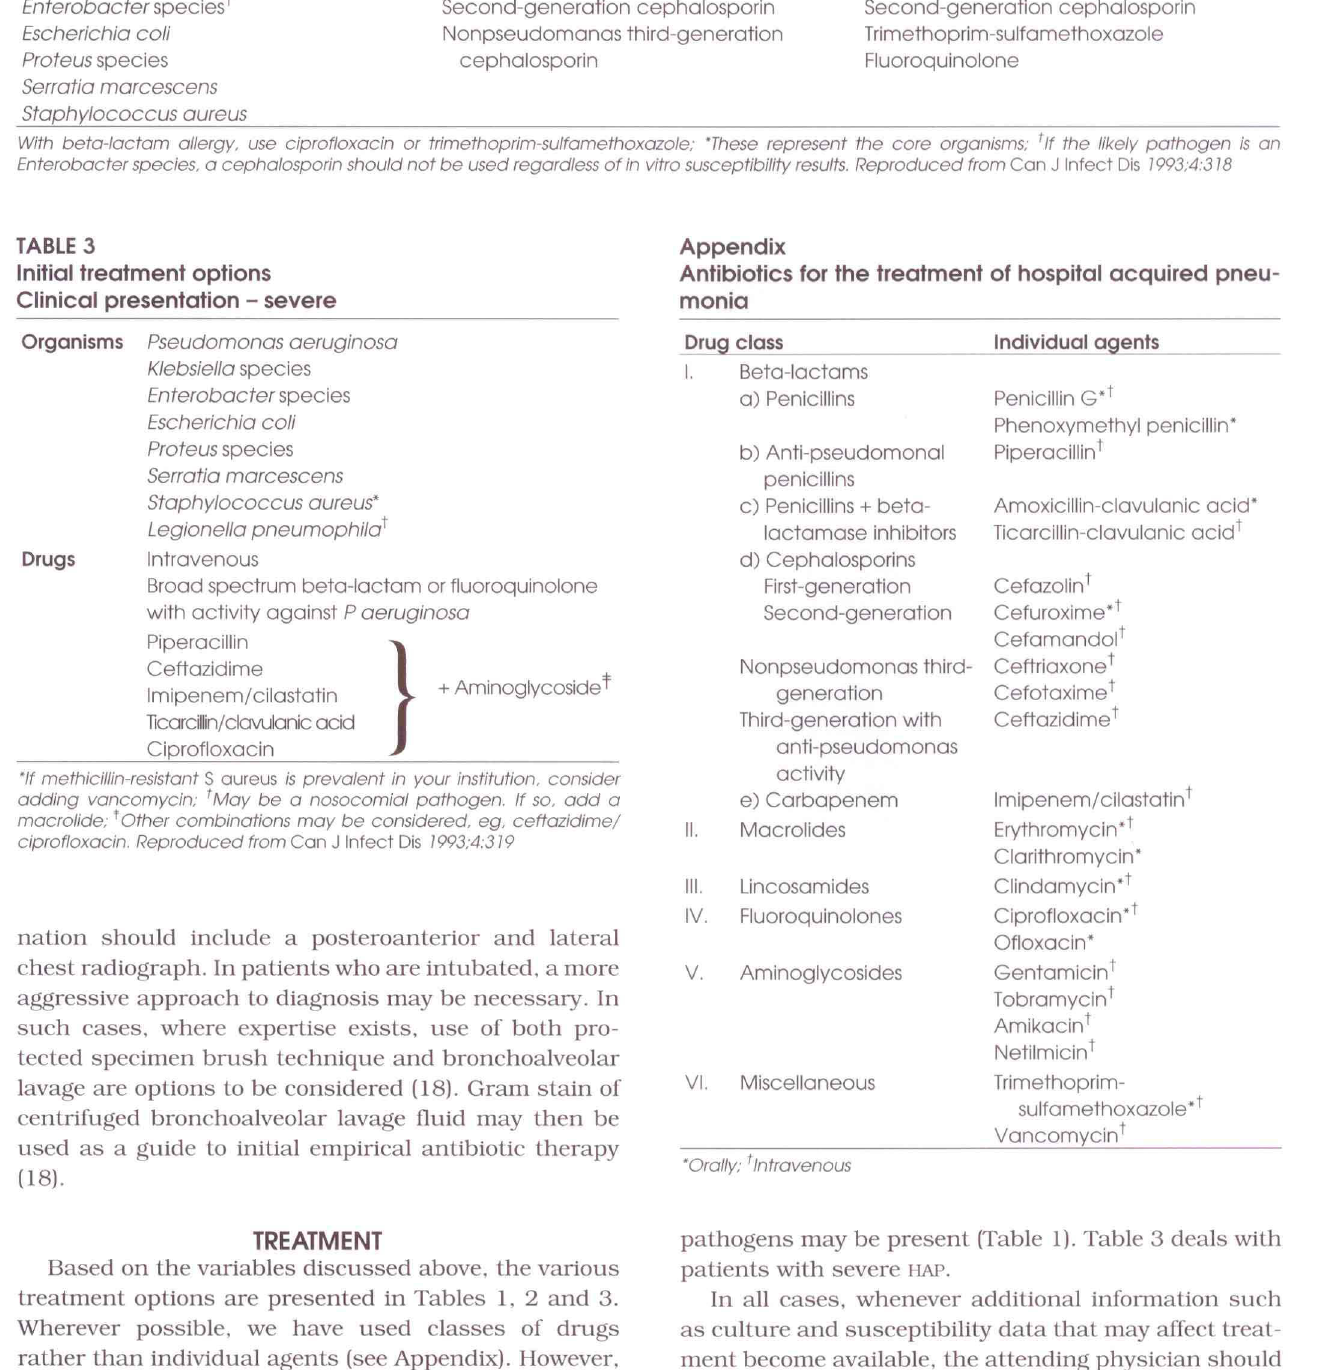
Initial treatment options for hospital acquired pneumonia Clinical presentation - mild to moderate; no unusual risk